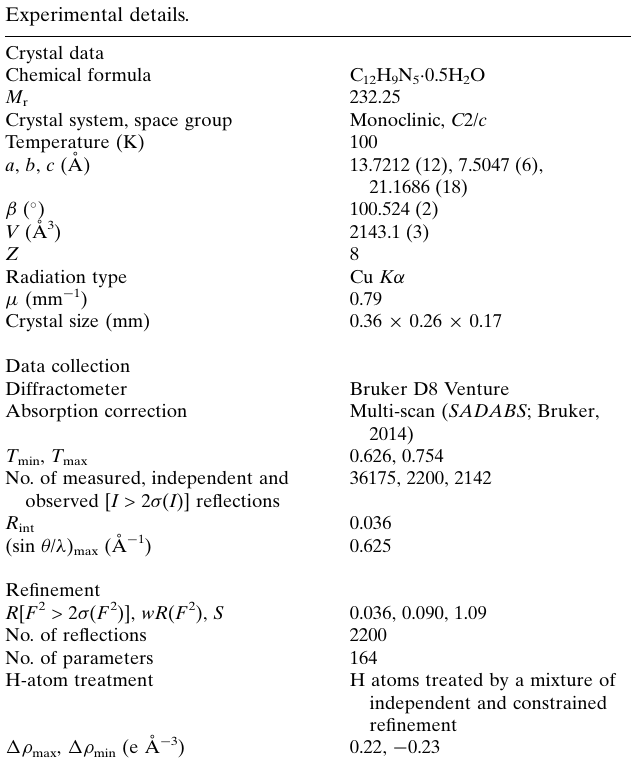
Table 2 Experimental